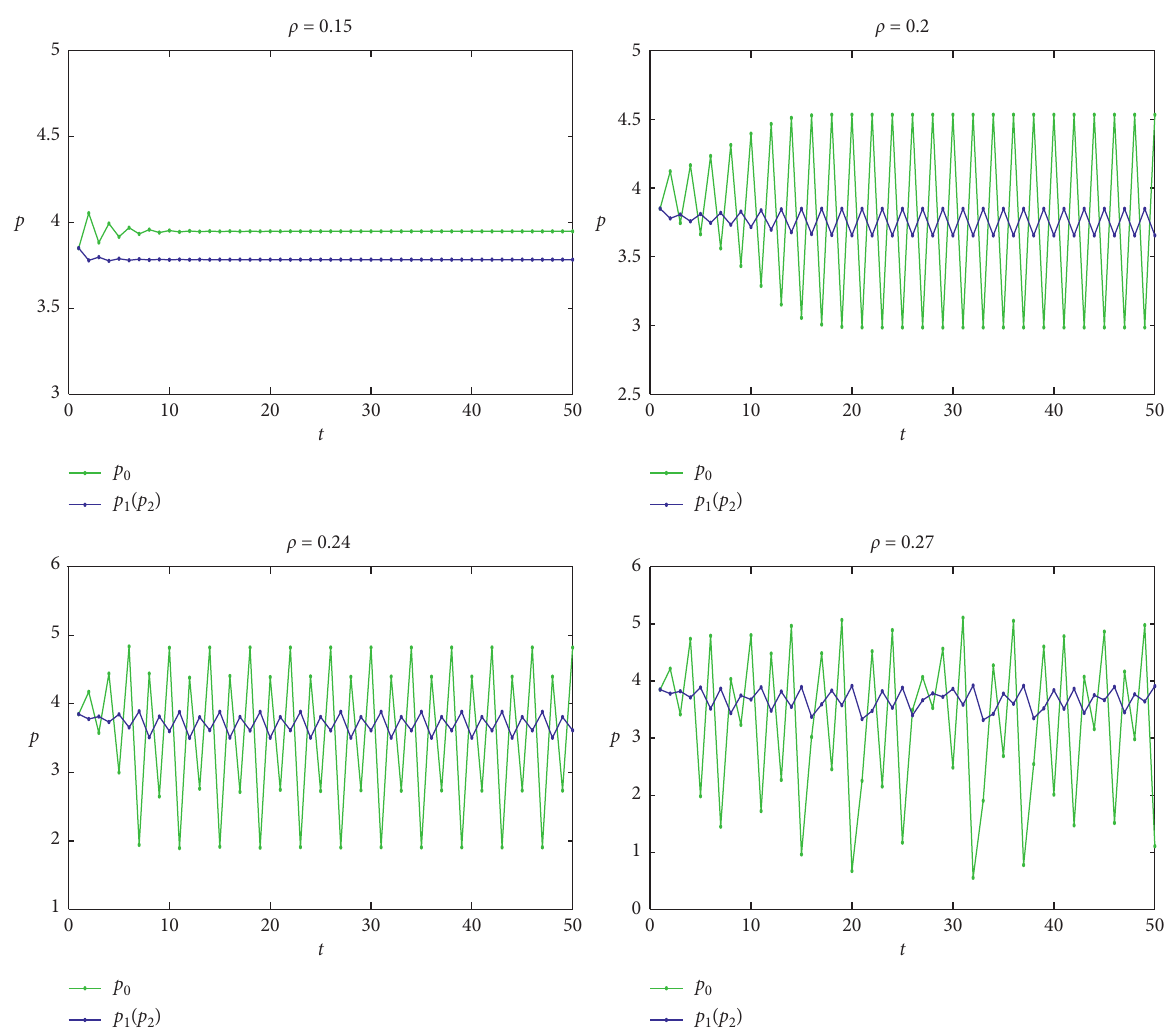
Figure 9: Evolutions for system (33) with various values of ρ